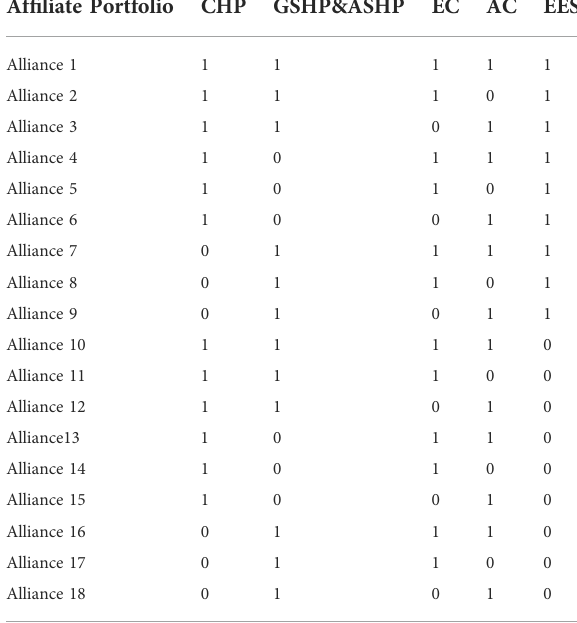
TABLE 3 Achievable gaming alliance